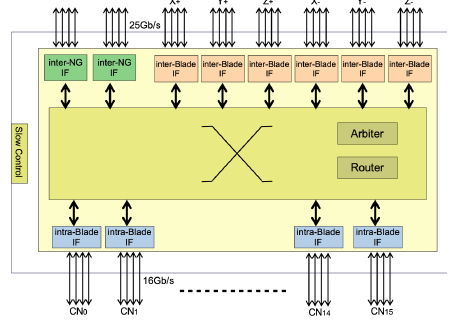
Figure 4. High-level block diagram of EuroEXA Custom Switch.